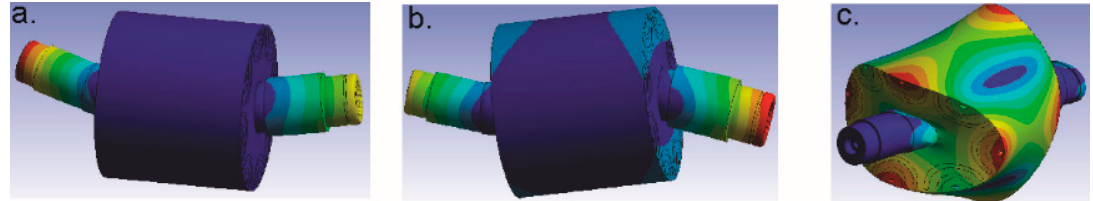
Figure 10. Numerical modal analysis of the IPM rotor with magnets and the shaft assembly: ( a ) the first bending mode f = 5212 Hz; ( b ) the second bending mode f = 5933 Hz; ( c ) the deformation of rotor and shaft f = 18,449 Hz. The deflections are indicated from minimum (blue color) to maximum (red color).